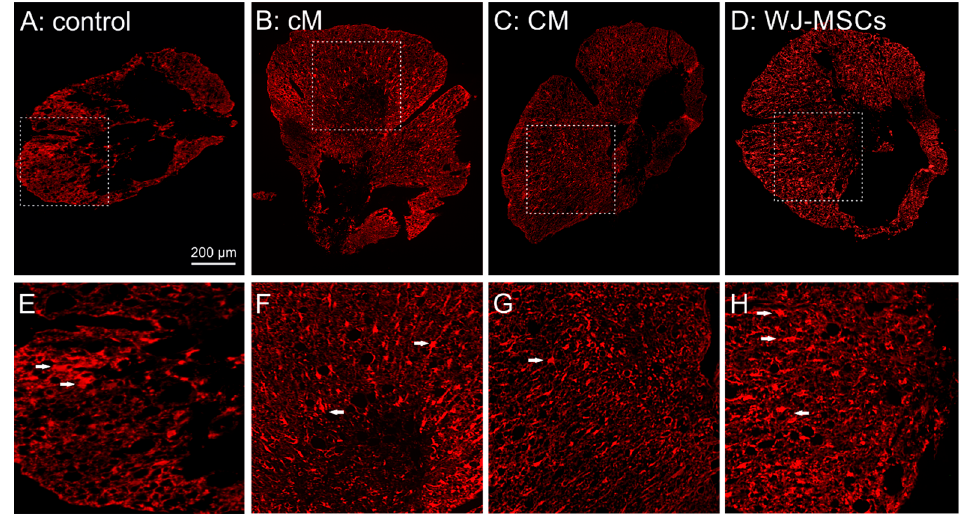
Figure 6. ( A – D ) Representative fluorescent images of GFAP staining of cross sections 9 weeks after the SCI for evaluation of the glial scar in the cranial part of the lesion, 5 mm from the centre. ( E – H ) highlight the details of the marked area in ( A – D ), with reactive astrocytes depicted by white arrows.